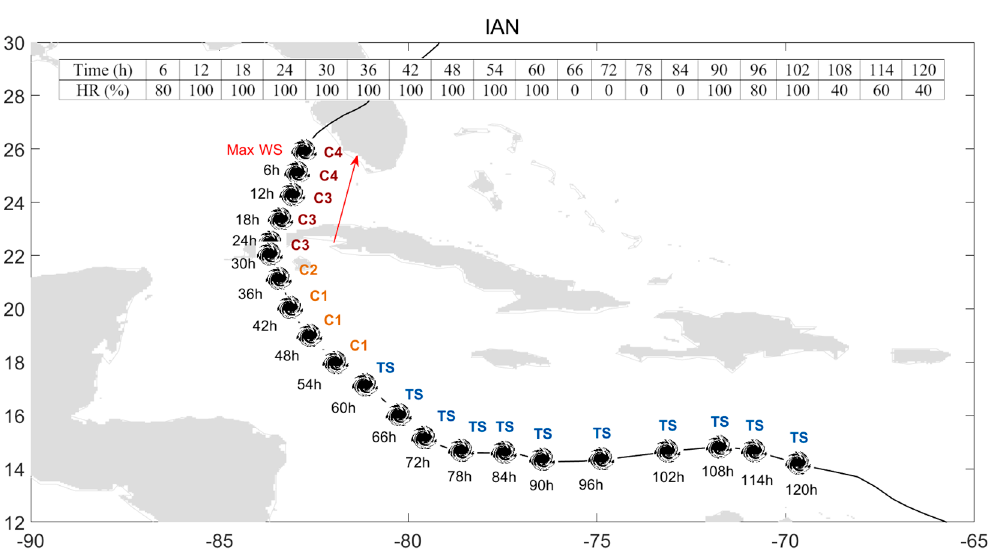
Figure 6. As in Figure 4, but for hurricane Emily (Atlantic Ocean, 11–21 July 2005). Here, the TS was formed on 12 July 2005, at 00:00 UTC and it reached the Max WS on 17 July 2005, at 00:00 UTC.